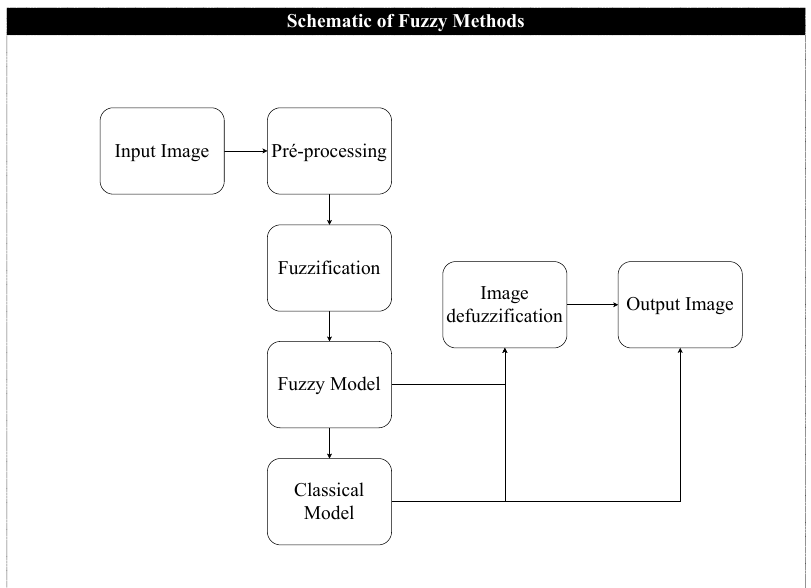
Figure 4. Schema of fuzzy-based